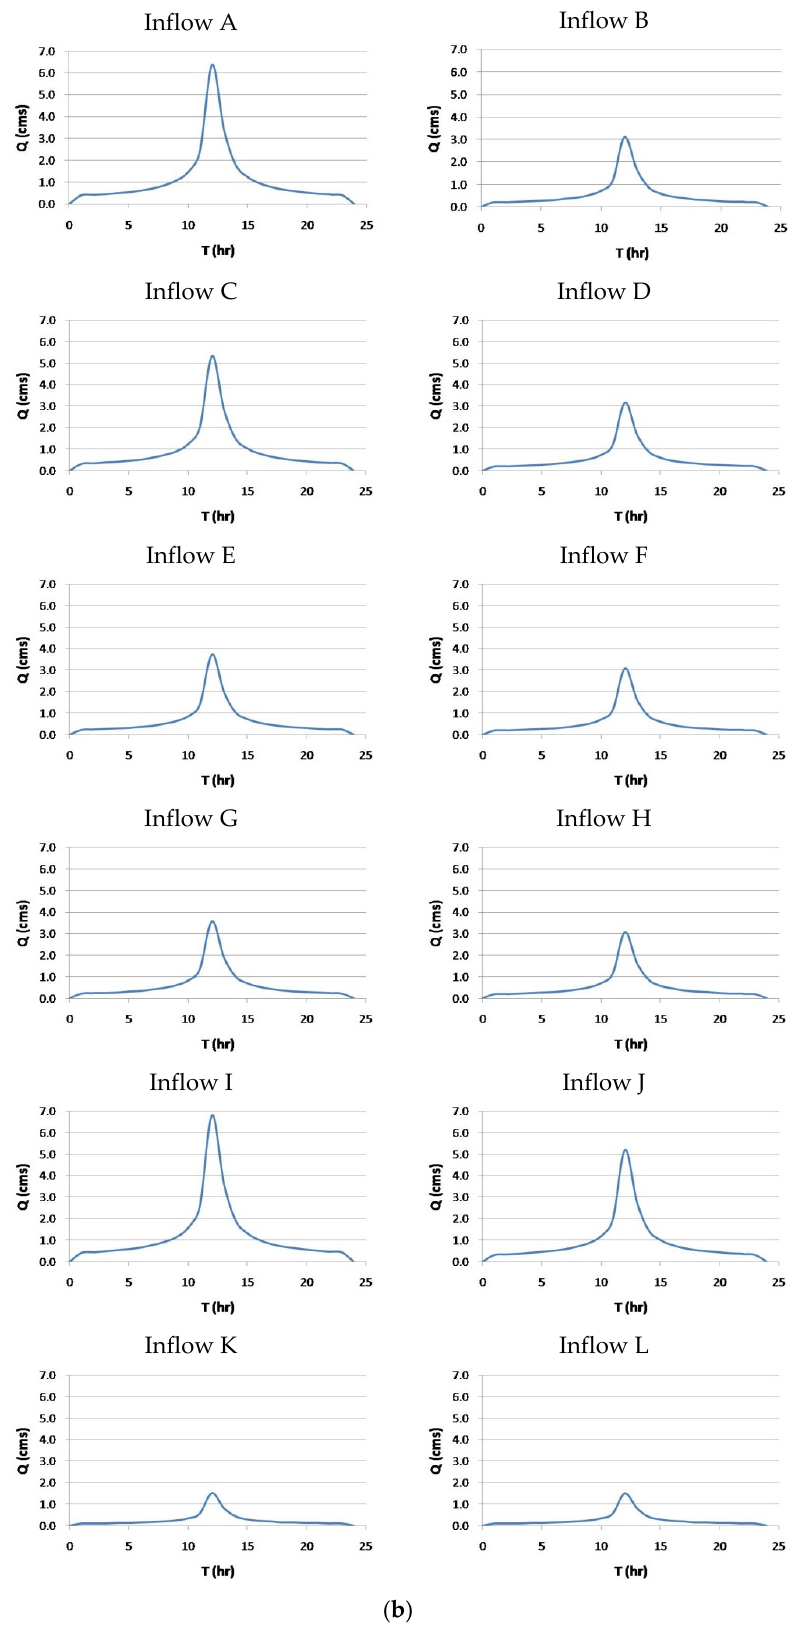
Figure 7. Simulation of inflow discharge hydrograph: ( a ) sub watersheds; ( b ) Inflow hydrographs A–L.